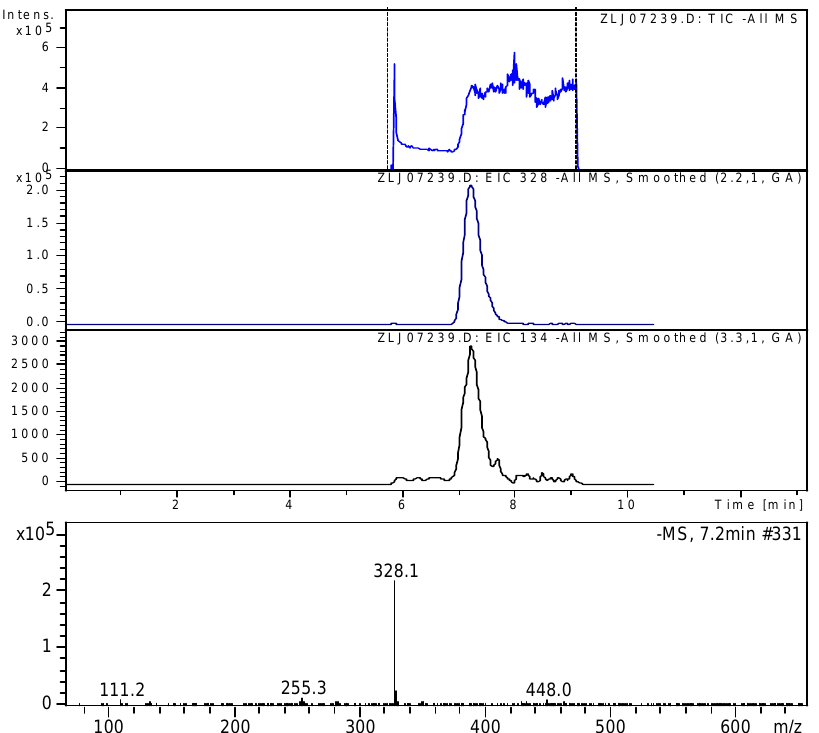
Figure 7 . Typical chromatogram of 100 pmol/ml 3´,5´-cAMP with HPLC-MS TIC mode.